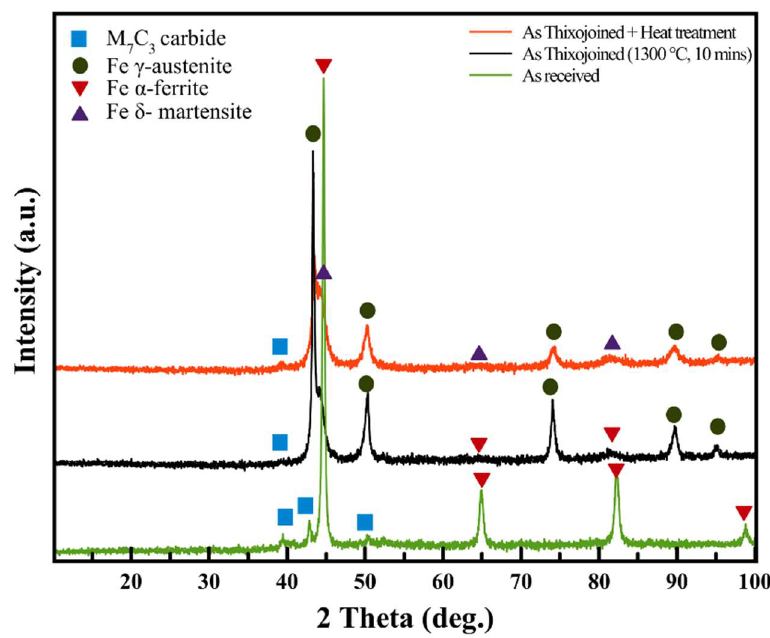
Figure 11. XRD patterns for AISI D2-AISI D2 joining processed at different conditions.